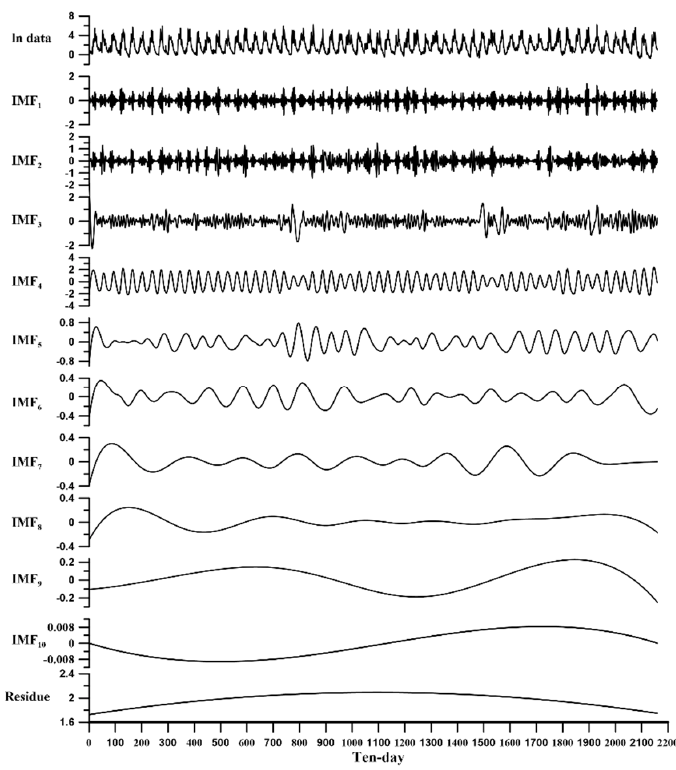
Figure 3. Results of EMD (empirical mode decomposition) method decomposition.